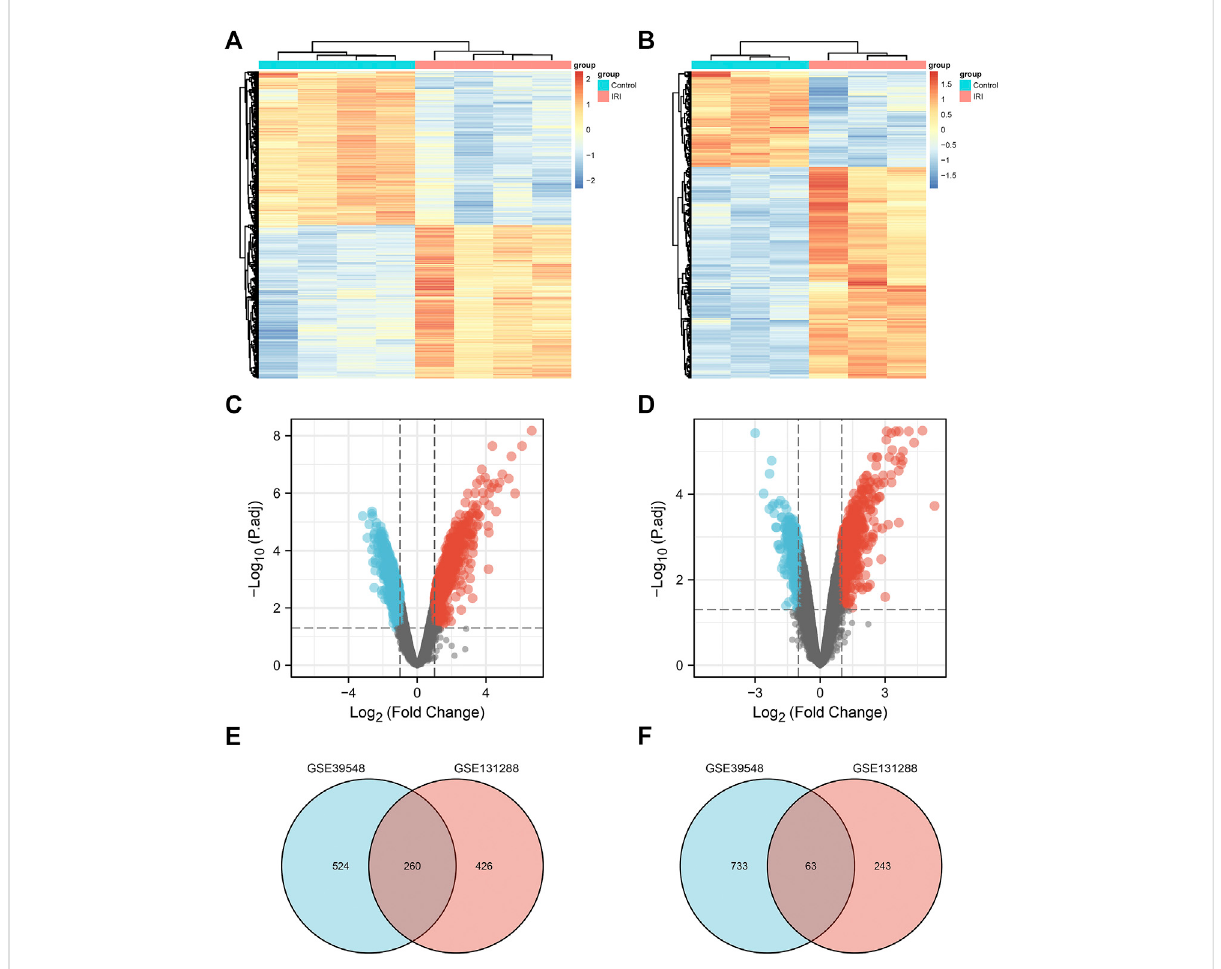
FIGURE 3 Differentially expressed genes. (A) Heatmap of the GSE39548 dataset; (B) heatmap of the GSE131288 dataset; (C) volcano map of the GSE39548 dataset; (D) volcano map of the GSE131288 dataset; (E) Venn diagram of the intersection of upregulated differentially expressed genes in GSE39548 and GSE131288; (F) intersection of downregulated differentially genes in the two